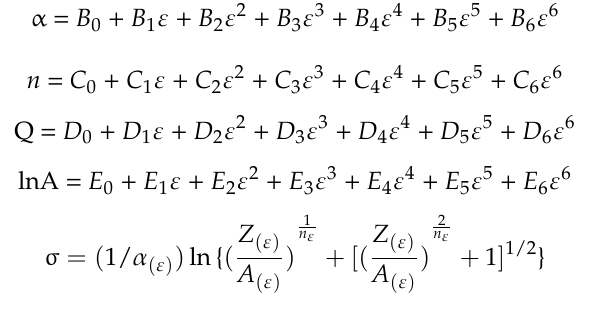
Figure 7. Relationships between material constants ( a ) α , ( b ) n , ( c ) Q and ( d ) ln A with true strain. The sixth order polynomials were employed to fit the relationships of these material constants and true strain and the fitting results are shown in Equations (10)–(13), the parameters in these equations are listed in Table 1. According to Equations (3) and (4), the true stress can be expressed by a function of the Zener − Hollomon parameter at a given true strain ( ε ), this function is shown in Equation (14). Then the material constants at a certain true strain determined by Equations (10)–(13) can be substituted into Equation (14) and the true stress under a given true strain can be determined.